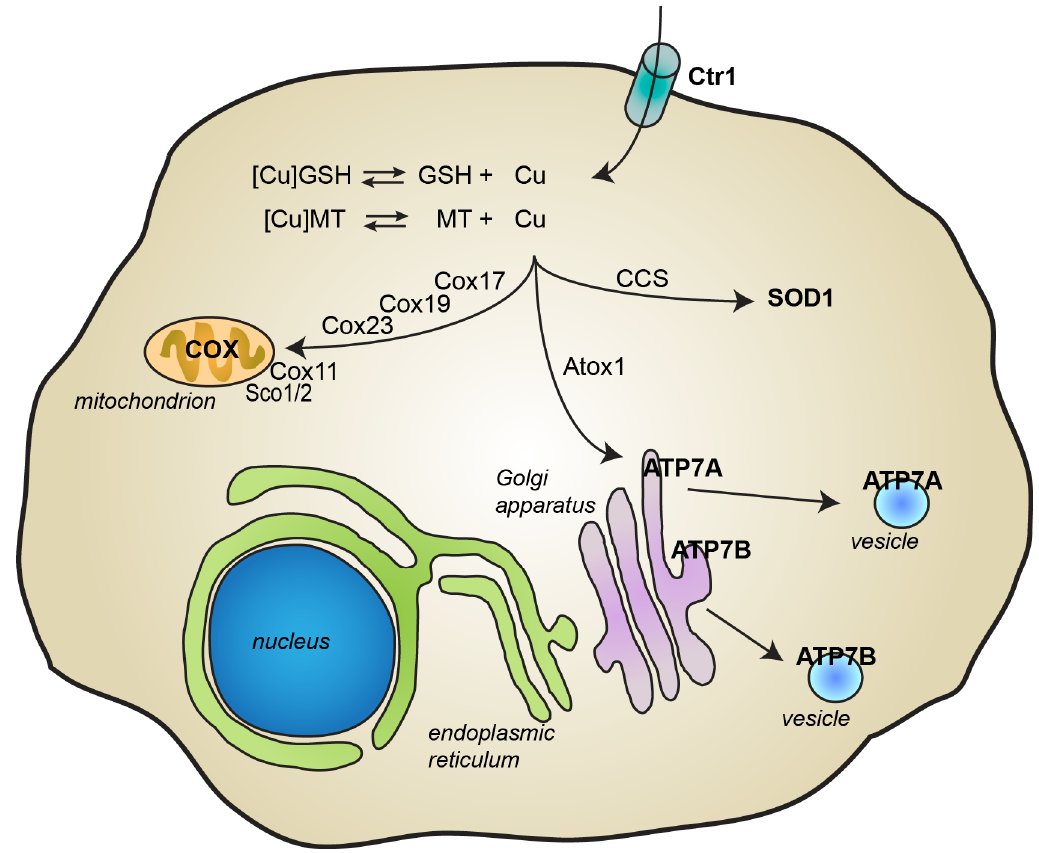
Figure 2. Cellular metabolism of copper. Copper import inside cells is mainly mediated by the copper transporter Ctr1. Inside cells, glutathione (GSH) and metallothioneins (MT) contribute to maintaining levels of free copper very low. Copper is transported to its final destination through the action of several specific chaperones. Copper transport protein Antioxidant-1 (Atox1) delivers copper to the P-type ATPases ATP7B and ATP7B, which are then responsible for the incorporation of copper into newly synthesized cuproproteins and for copper excretion through the plasma membrane. Copper chaperone for SOD1 (CCS) delivers copper to superoxide dismutase 1 (SOD1). At least 6 chaperones (Cox 11, Cox17, Cox19 and Cox23, and Sco1 and Sco2) deliver copper inside mitochondria into cytochrome c oxidase.